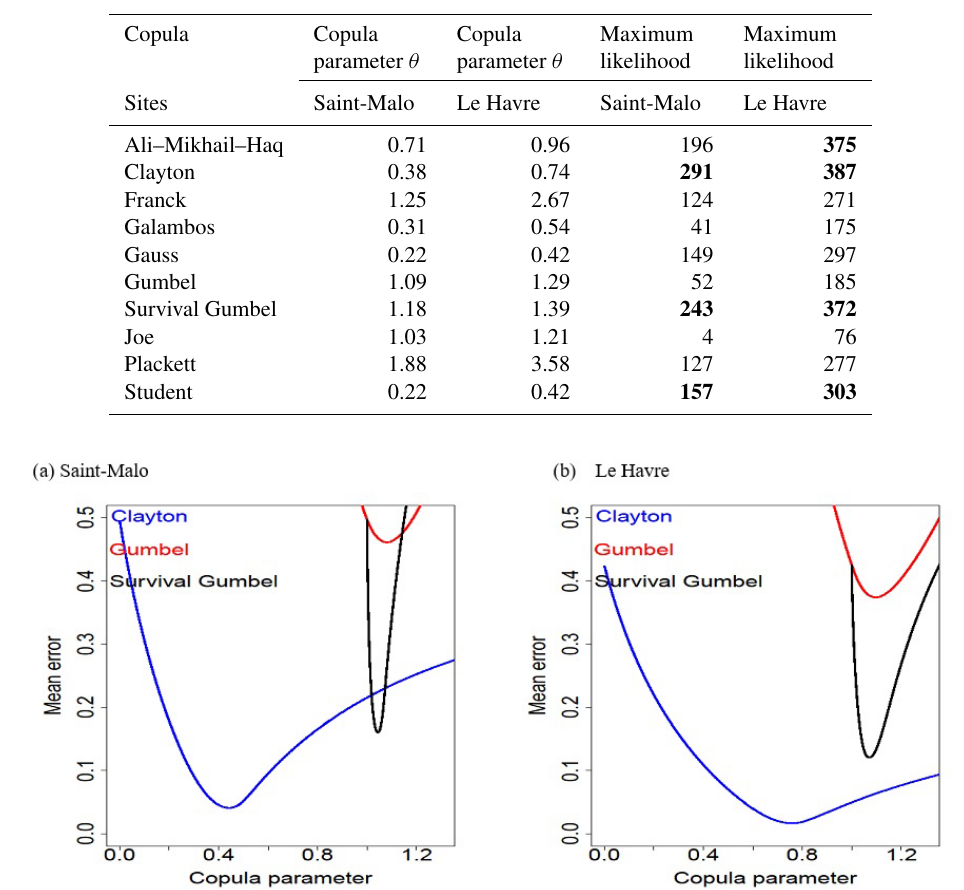
Table 2. Copula parameter and maximum likelihood for the different survival copulas in Saint-Malo and Le Havre.